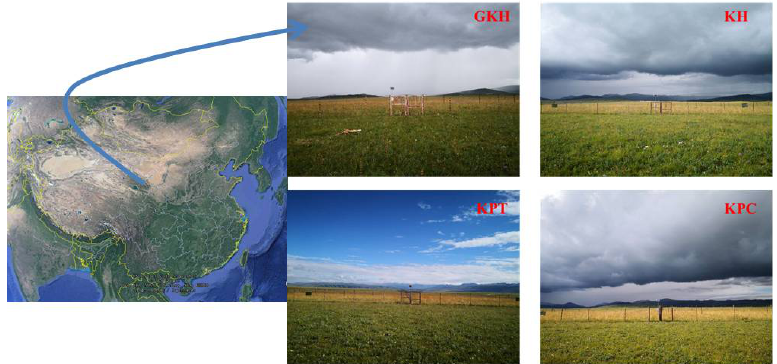
Figure 1. Study sites. Note: Plot names are “GKH”, “KH”, “KPT” and “KPC” are for the grazing intensities of 3.75 ± 0.75 sheep/ha, 7.25 ± 0.25 sheep/ha, 8.50 ± 0.35 sheep/ha and 11.75 ± 0.95 sheep/ha respectively. Photos were taken by Li Lin. Table 1. General overview of the study